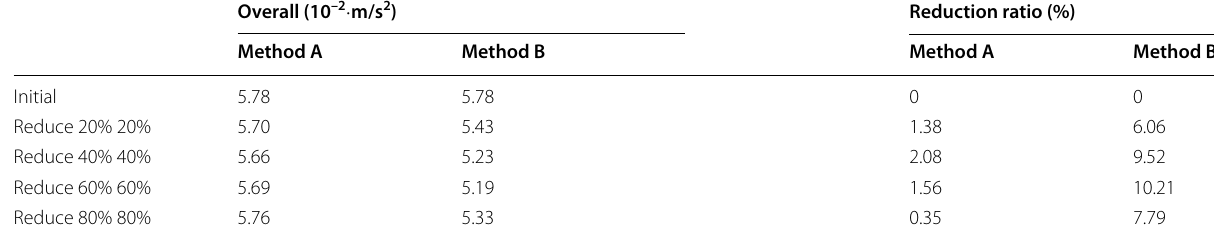
Table 4 Comparison of optimization methods